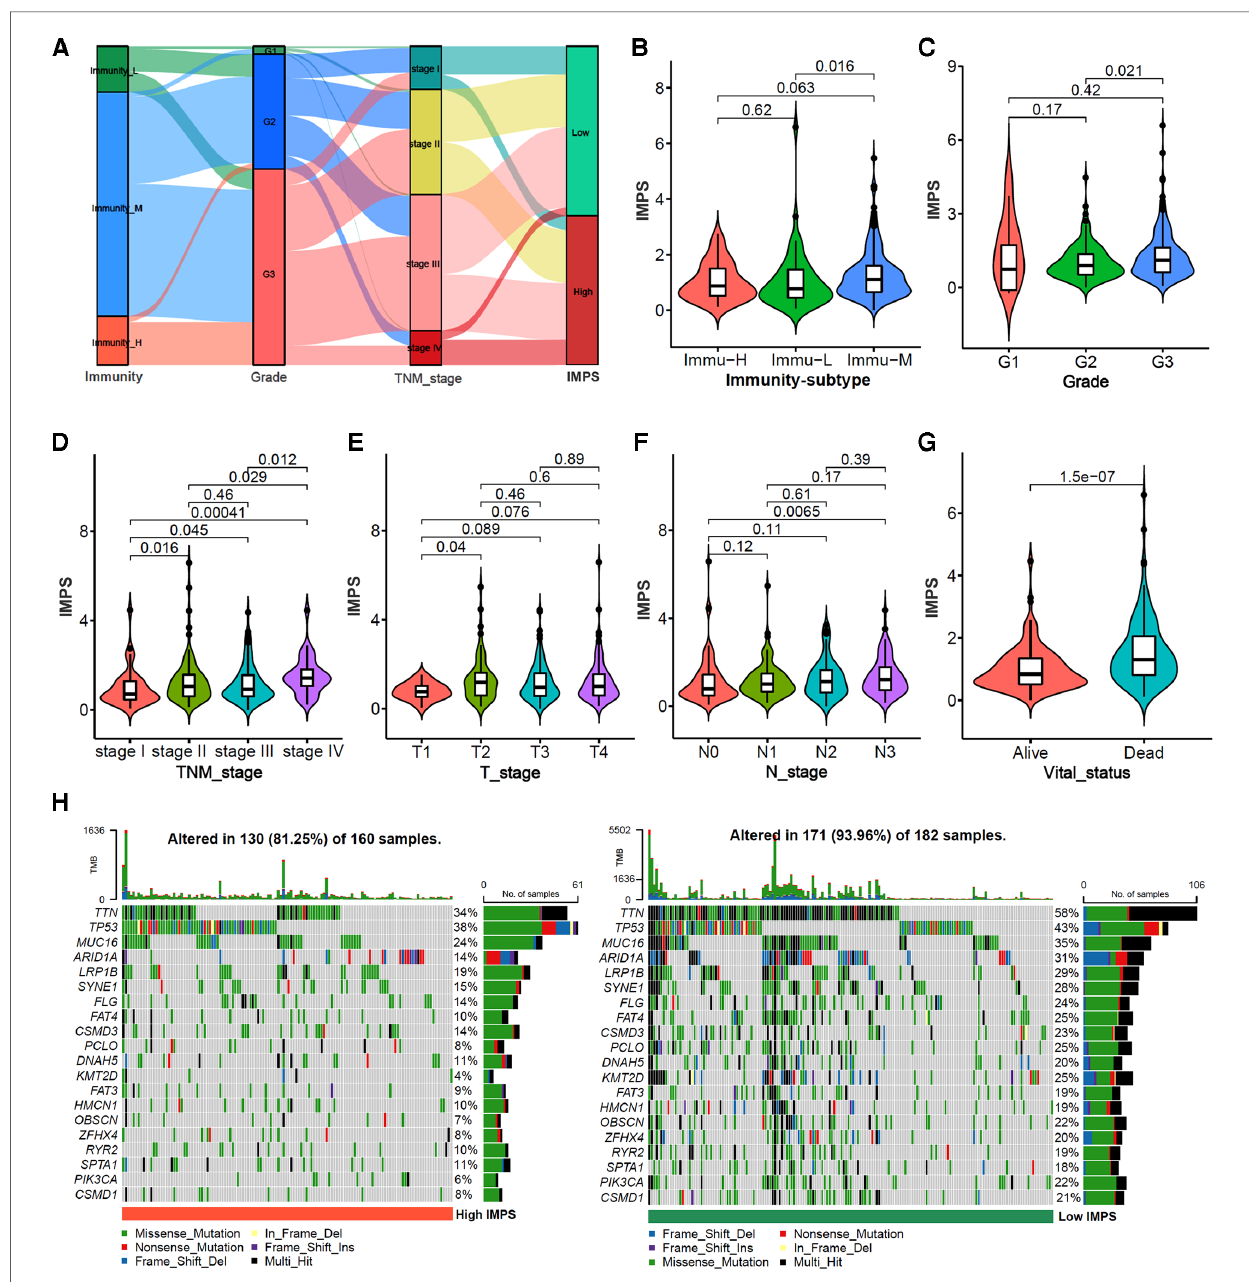
FIGURE 7 Correlation analysis of IMPS with clinical characteristics and somatic mutations. ( A ) Alluvial diagram of immunity-subtypes with different pathological grades, TNM stages and IMPS subgroups. ( B – G ) Comparison of IMPS among different immune subtypes, pathological grades, T stages, N stages and vital status. ( H ) mutation landscape of gastric cancer between high-IMPS (left) and low-IMPS (right)